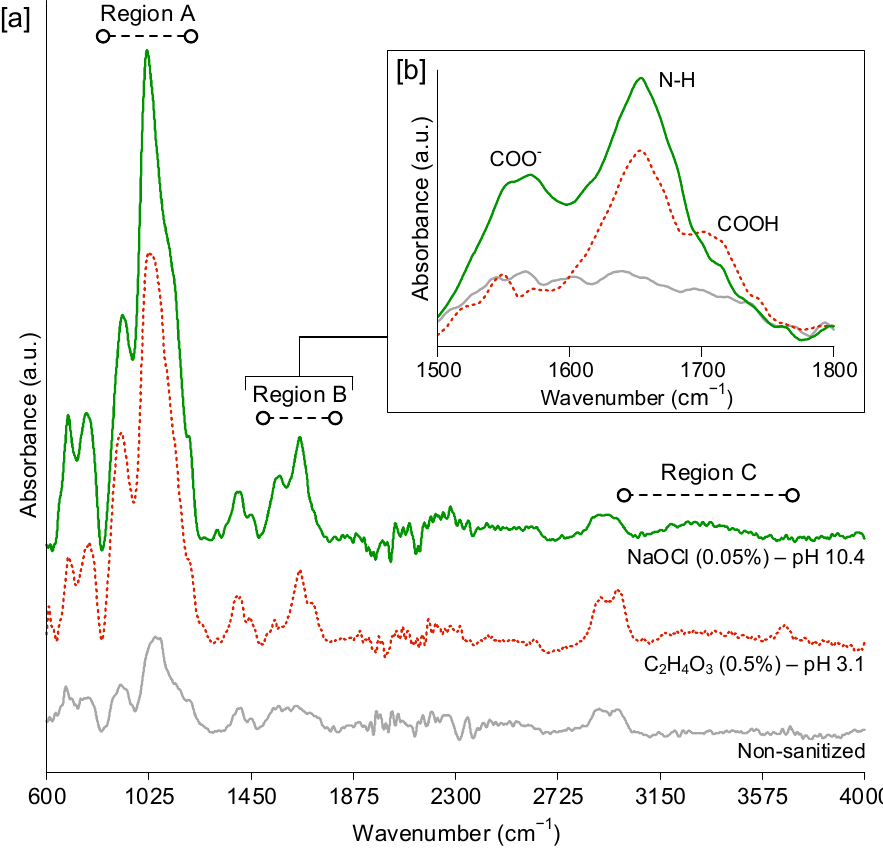
Figure 4. ( a ) FTIR-ATR spectra of the coating AP10 + AA6 non-sanitized (gray line) and after five sanitization cycles with sodium hypochlorite (0.05%) (green line) and peracetic acid (0.5%) (red dotted line); ( b ) close view of the region related with the presence of COOH groups and COO - anions.